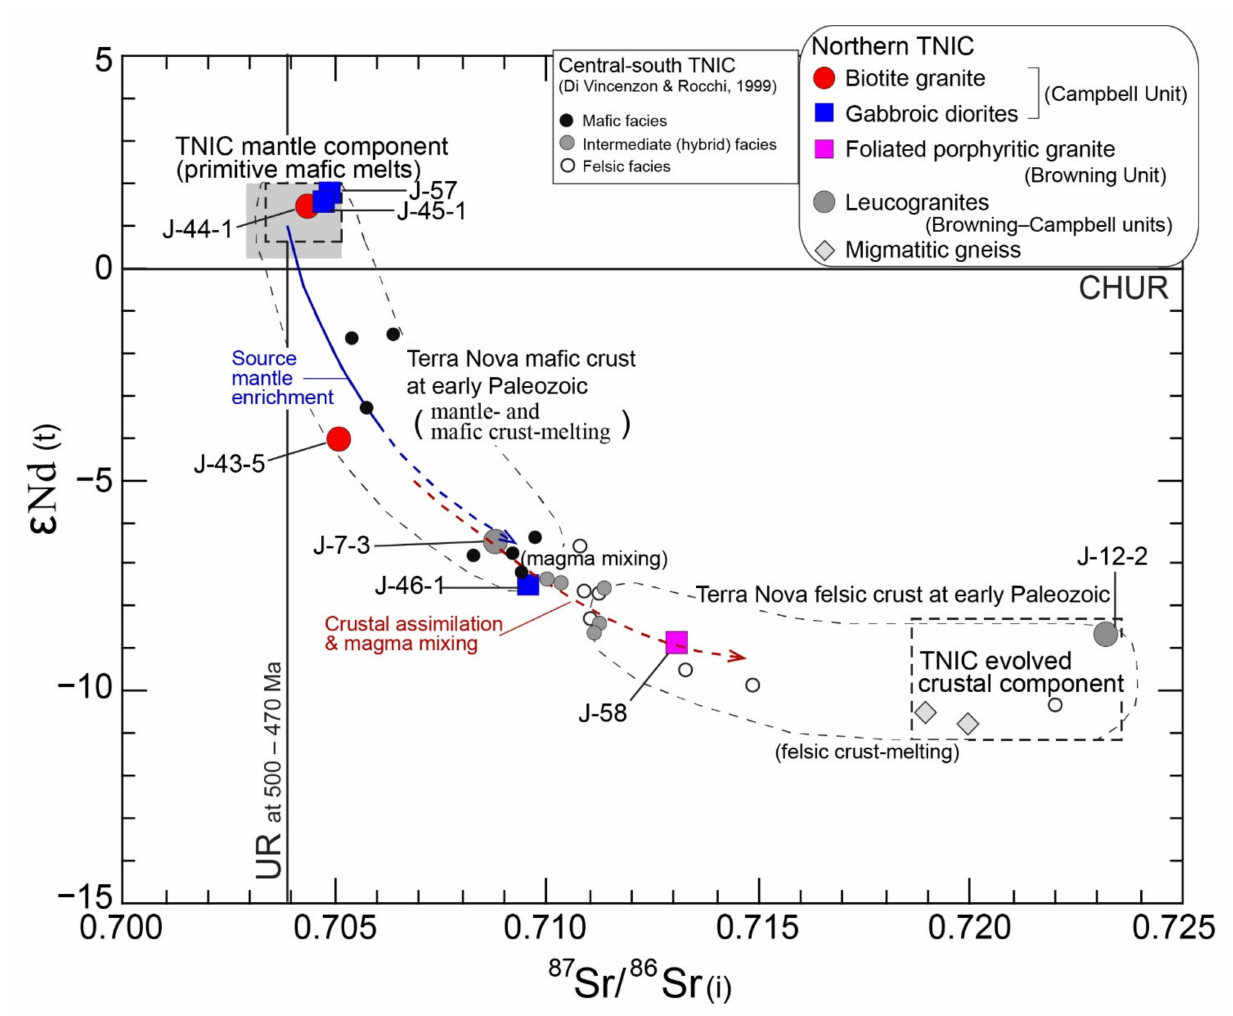
Figure 9. Whole-rock 87 Sr/ 86 Sr (i) vs. ε Nd (t) plot for the BIU–CIU samples. Reference data for the south-central TNIC are taken from Di Vincenzo and Rocchi [12]. The TNIC mantle component was estimated based on data in the present and previous studies [12,13]. Present-day 147 Sm/ 144 Nd (0.1967) and 143 Nd/ 144 Nd (0.512638) ratios of the chondritic uniform reservoir (CHUR) are from Wasserburg et al. [47] and DePaolo [48]. Present-day 87 Rb/ 86 Sr (0.0827) and 87 Sr/ 86 Sr (0.7045) ratios of the undifferentiated reservoir (UR) are from DePaolo [48] and Faure